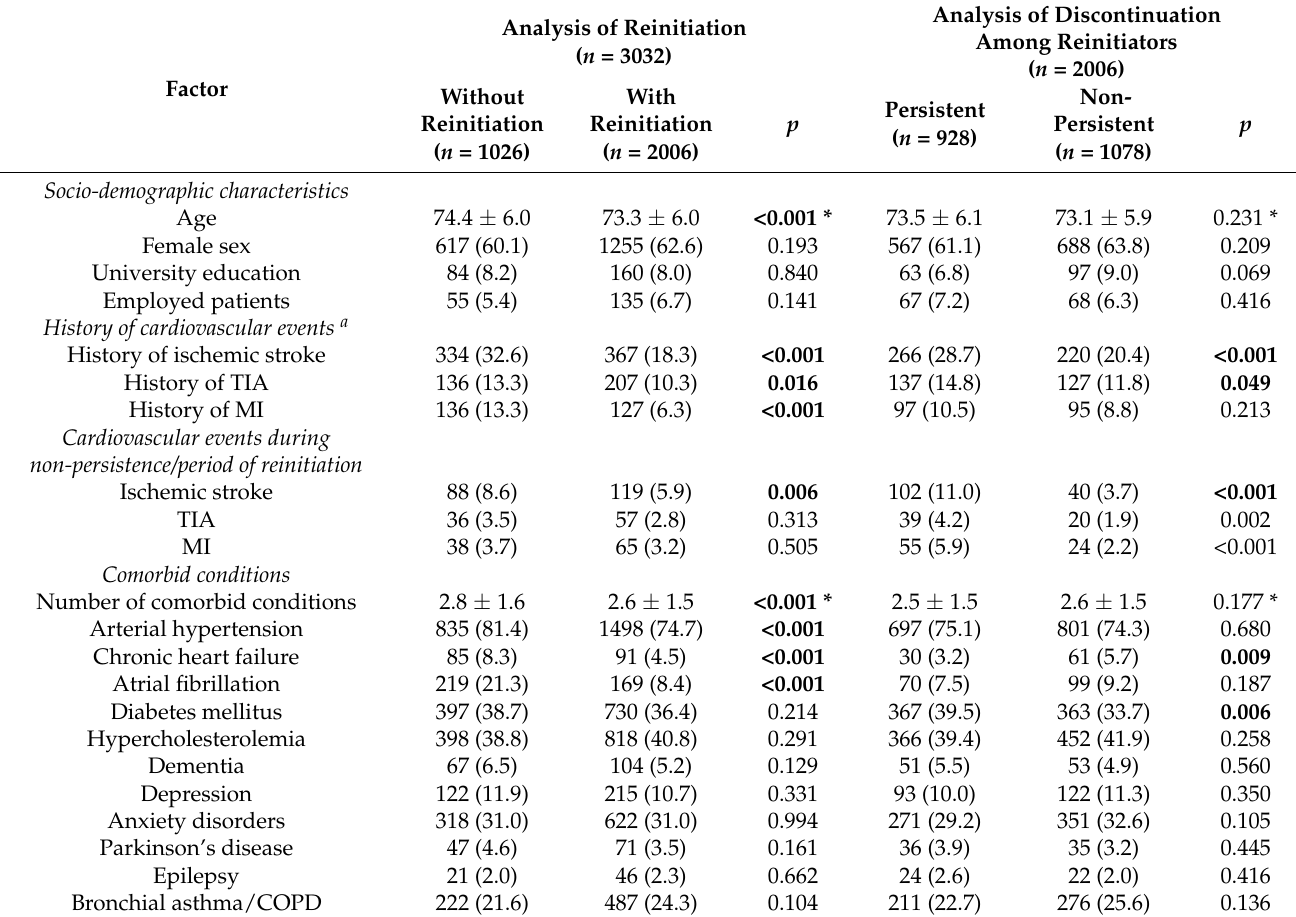
Table 1. Baseline characteristics of the study